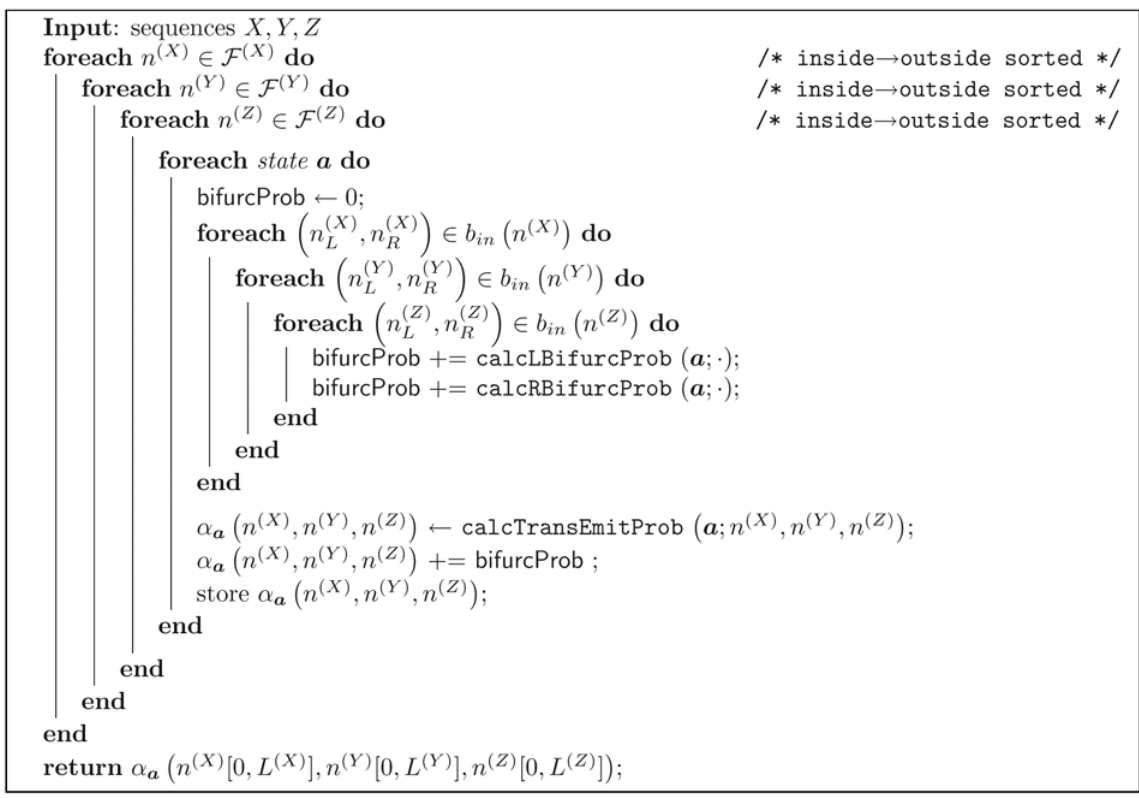
Figure 1. Algorithm 1. The constrained Inside algorithm for three sequences X , Y , Z . Ensemble states a in the iteration over states are sorted in Inside fill order with Emit states first, then Null states in reverse topological order. doi:10.1371/journal.pcbi.1000483.g001 PLoS Computational Biology |